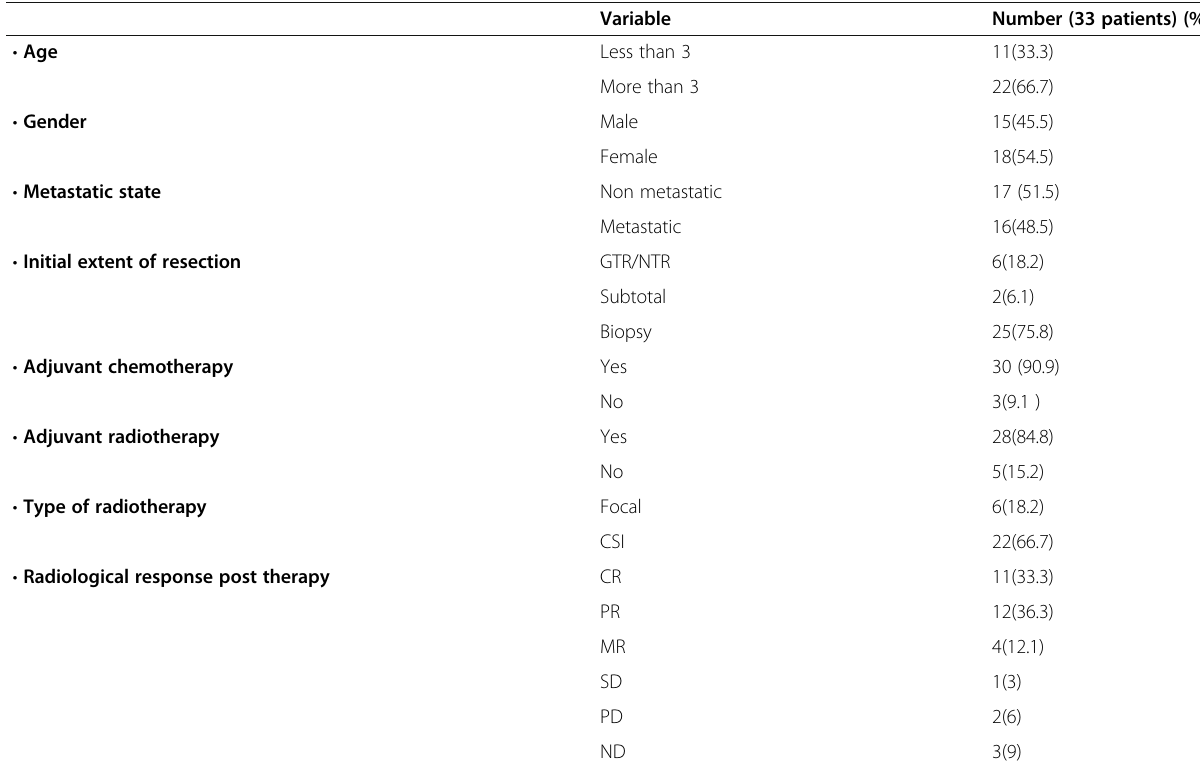
Table 1 Baseline characteristics of the studied patients